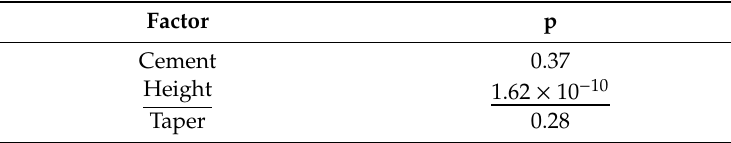
Table 2. Average forces during retrieval: KW test